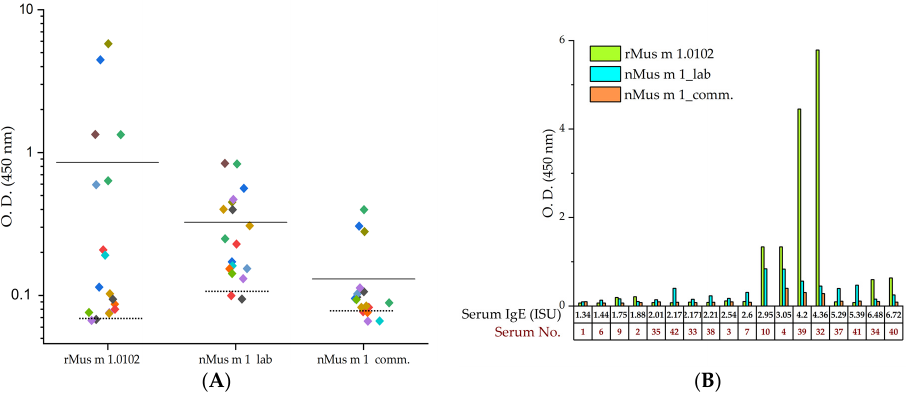
Figure 3. Indirect ELISA for the detection of IgE antibodies binding to Mus m 1 allergen from different sources. ( A ) Binding signals of recombinant Mus m 1.0102 and nMus m 1 samples (laboratory and commercial preparations) to serum IgE molecules are presented as O.D. at 450 nm. Discrete values are displayed in different colours according to the allergic sera, with the bold horizontal line representing the mean O.D. value. The dashed lines represent the mean signal obtained with control sera in each ELISA test. The distributions of each ELISA dataset obtained with IgE-positive and control sera are significantly different (Mann–Whitney test). y axis is in log 10 scale. ( B ) Results of the indirect ELISA are reported as a function of increasing Mus m 1-specific IgE concentration (meas- ured by ImmunoCAP ISAC test). Volume of serum No. 10 was insufficient for testing with Mus m 1 commercial preparation.